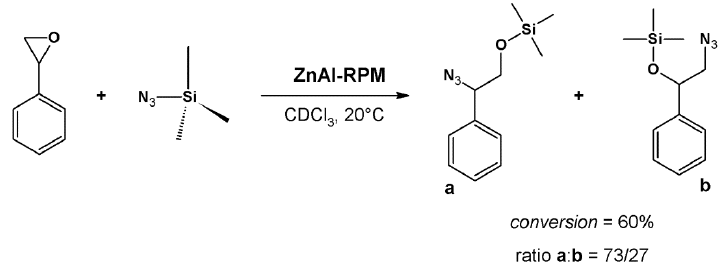
Figure 13. Ring opening of styrene oxide catalyzed by